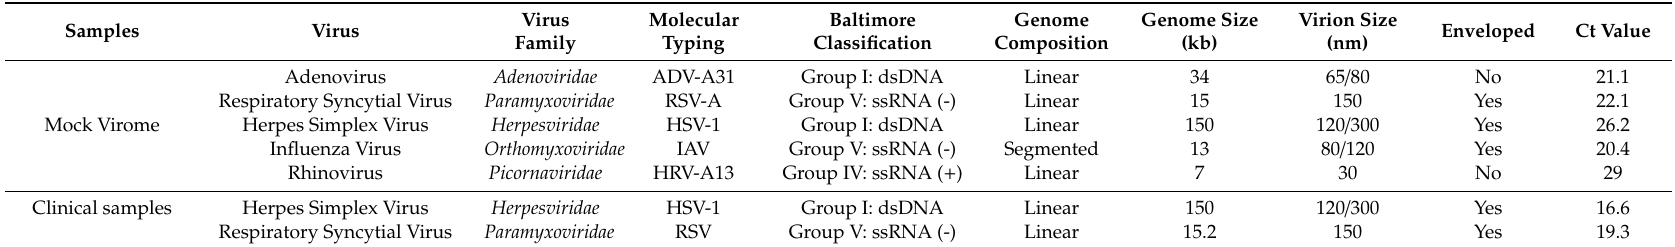
Table 1. List of the five selected viruses included in the mock virome and the clinical respiratory samples. The mock virome consists of known concentrations of five viruses isolated from respiratory samples, selected as representatives of a wide range of virus characteristics (virion size, the presence or absence of an envelope, genome length, genome type (dsDNA, ssRNA), and genome composition (linear, segmented)). All the viruses were provided by the virology laboratory (Hospices Civils de Lyon). Human clinical respiratory samples were obtained from hospitalized patients. dsDNA: double stranded DNA; ssRNA: single stranded RNA.